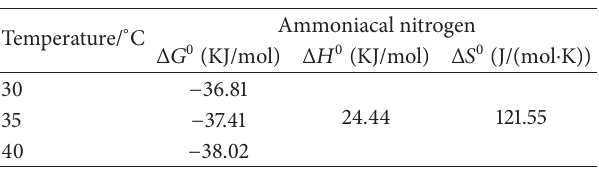
Table 2: Thermodynamic parameters of ammoniacal nitrogen adsorption on